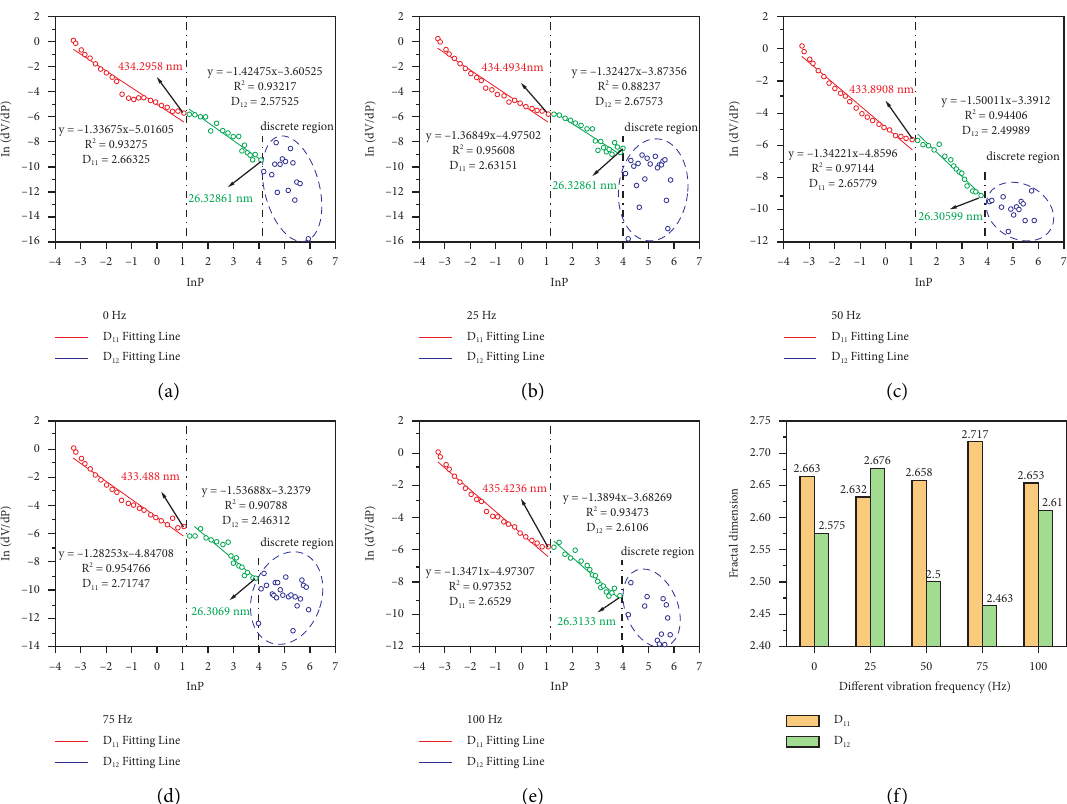
Figure 9: Fractal dimension of macropores and mesopores of the VDF coal samples: (a–e) the fractal characteristics of the macropores and mesopores at 0, 25, 50, 75, and 100Hz vibration-based MIP data, respectively; (f) fractal trend of D 11 and D 12